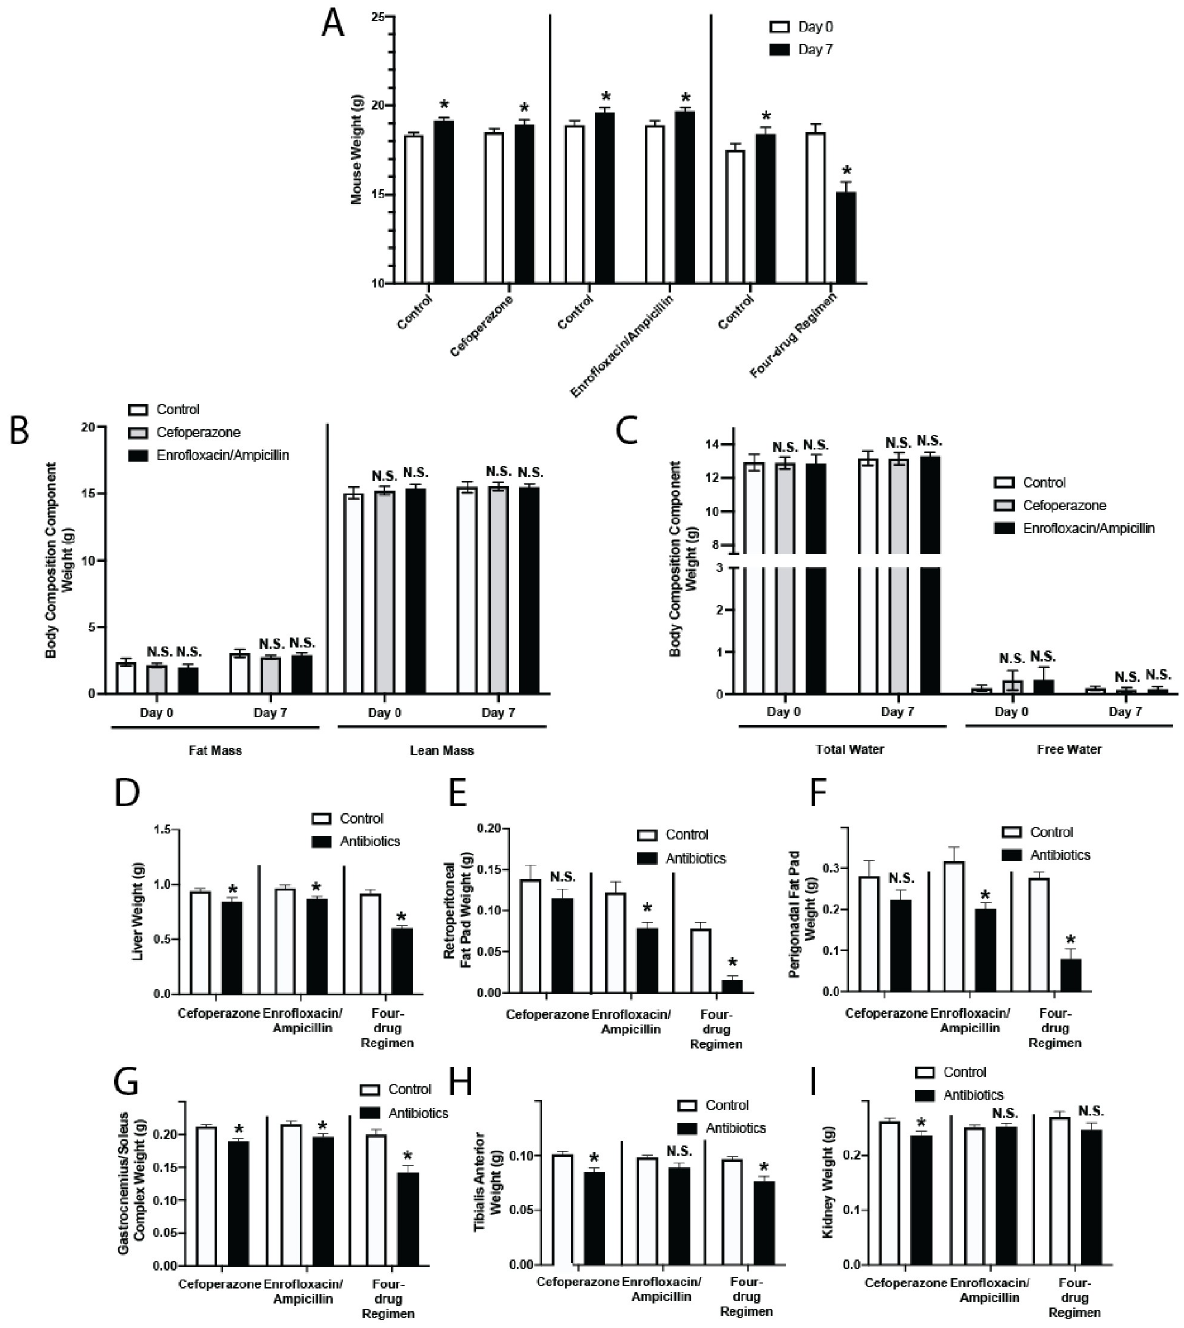
Fig 2. Commonly administered enteral antibiotic regimens have profound yet variable effects on host metabolism. Mice were given an oral regimen of antibiotics: (1) 0.5 g/L cefoperazone; (2) 0.27 g/L enrofloxacin and 1 g/L ampicillin; (3) 1 g/L neomycin, 1 g/L ampicillin, 1 g/L metronidazole, and 0.5 g/L vancomycin (the “four-drug regimen”); in distilled drinking water. Control mice were given distilled drinking water alone. Mice were given ad libitum access to food and water. (A) Comparison of mouse body weights at 0 and 7 days. Error bars denote SEM. n = 10– 20, � P < 0.05. (B-C) NMR whole body composition analysis of mice treated with enrofloxacin/ampicillin and cefoperazone regimens. Mice were analyzed at day 0 (immediately prior to antibiotic administration) and day 7 (at the conclusion of antibiotic therapy). n = 10, N.S. = not significant, P > 0.05. (B) Fat mass and lean mass. (C) Total body water and free body water. (D-I) Mice were necropsied on day 8 of treatment and weights of liver (D), retroperitoneal fat pads (E), perigonadal fat pads (F), bilateral gastrocnemius-soleus complex muscles (G), bilateral tibialis anterior muscles (H), and bilateral kidneys (I) were compared to their respective controls. n = 10, � P < 0.05. Error bars denote SEM.